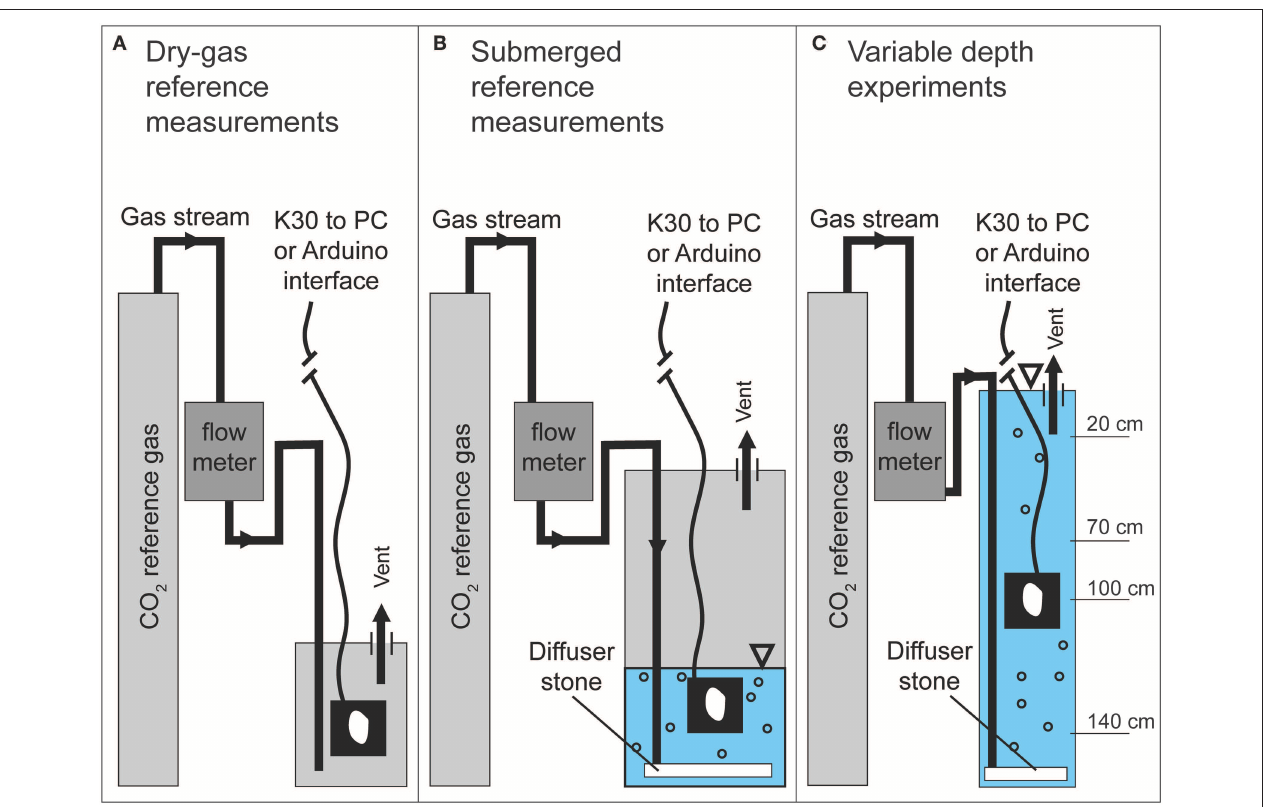
FIGURE 3 | Schematic of reference measurement configurations for (A) dry-gas, (B) submerged, PCO 2 , and (C) variable depth experiments. Not to